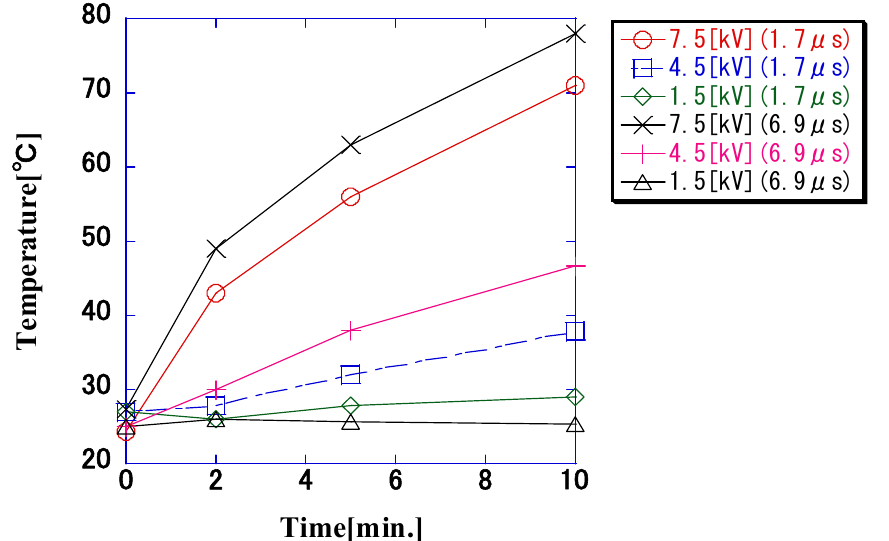
Figure 9. Temperature changes observed in the bacterial suspension (8.0 × 10 5 CFU/mL) due to impulse voltage application. The temperature of the bacterial suspension increased with increases in the applied voltage and pulse width. At a voltage of 7.5 kV and a pulse width of 6.9 µ s, the bacterial suspension reached a maximum temperature of 78.5 °C.